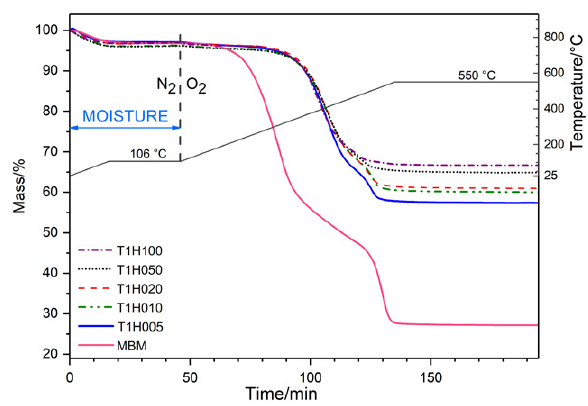
Figure 3. Ash-content determination for T1ABC curves at all five heating rates and MBM sample up to 550 °C.